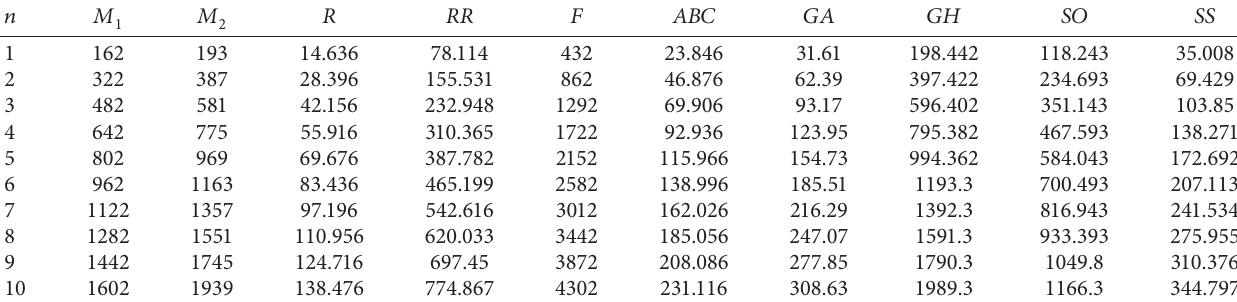
Table 4: Numerical representation of the computed indices for guar gum.